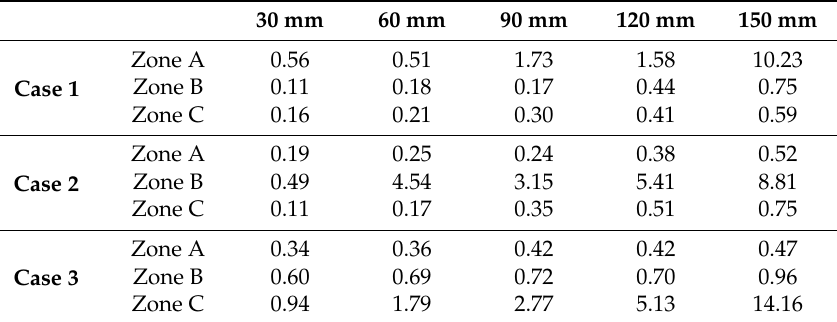
Table 1. Calculated RMSD values for Cases 1, 2, and 3.